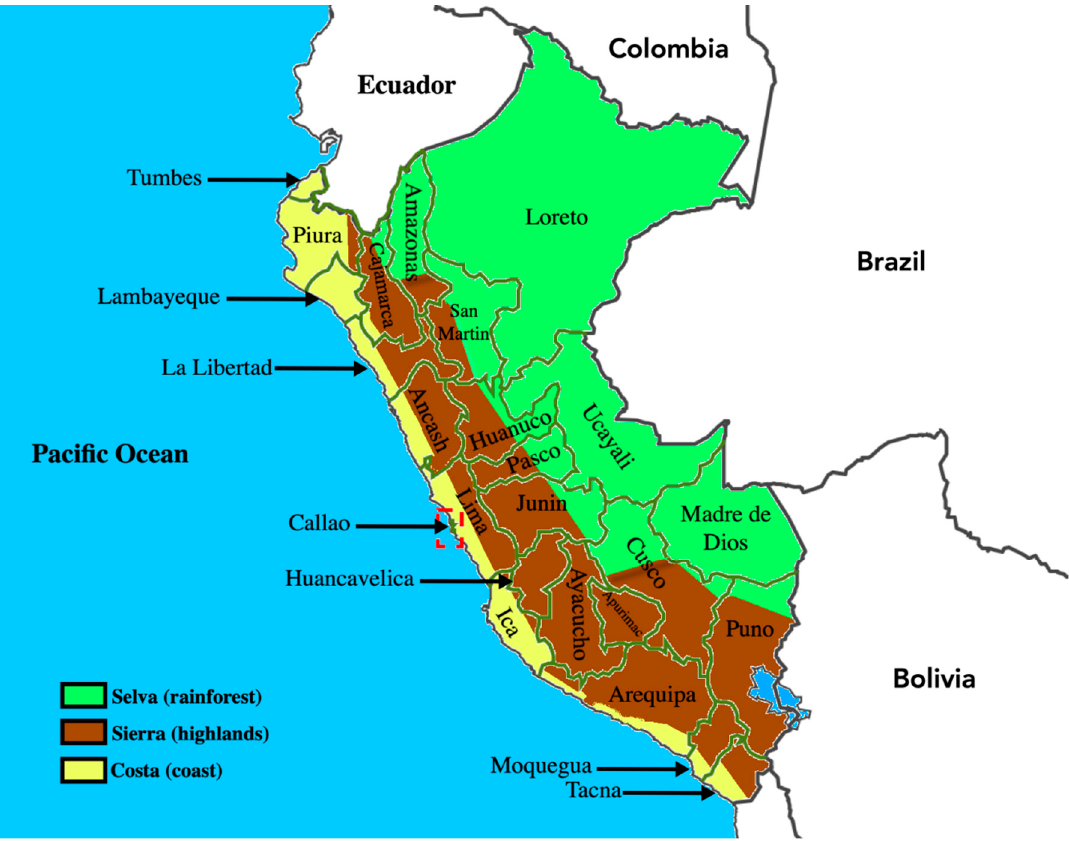
Figure 1. Map of Peru, showing its three geographical regions and 25 departments. ArcGIS 10.8.1 software (http://www.esri.com/software/arcgis, accessed on 5 May 2021) was used to develop the map.